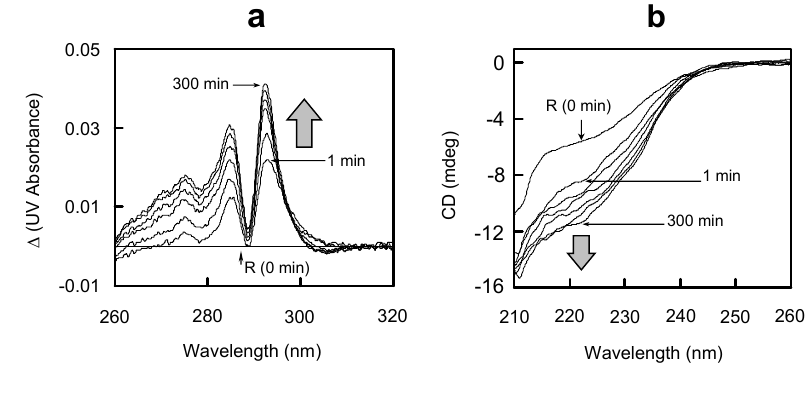
Figure 7. ( a ) Differential UV spectra and ( b ) CD spectra of the folding solutions of HEL at 5 °C and pH 8.0 in the presence of 2 M urea. Folding conditions were ( a ) [R] = [DHS ox ] /3 = 11.0 µM and ( b ) [R] 0 0